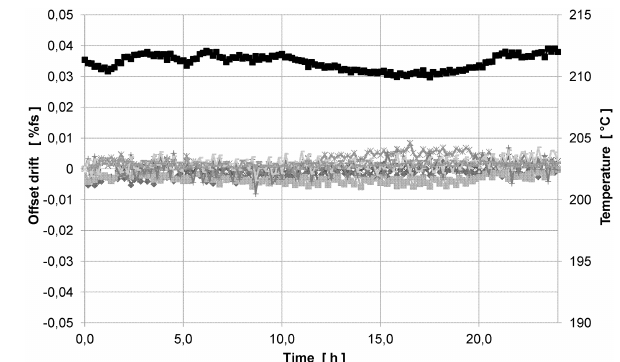
Figure 14. Offset drift at 210 ◦